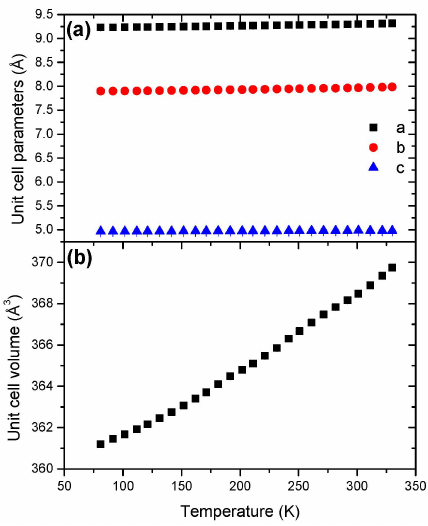
Figure 10. Temperature dependence of ( a ) the unit cell parameters and ( b ) the unit cell volume for NaHB in the temperature range 81–328 K.